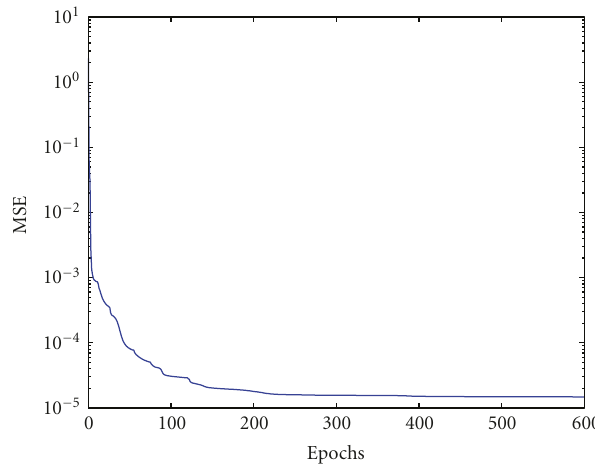
Figure 22: FCNN structure learning